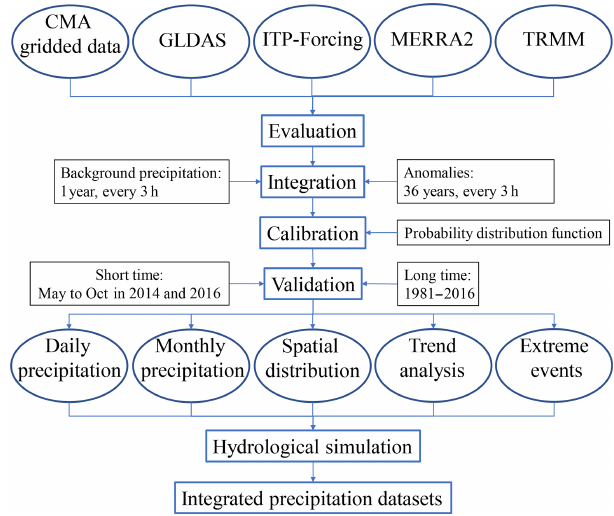
Figure 2. The flowchart used to produce the spatiotemporal contin- uous precipitation dataset ( P _int).